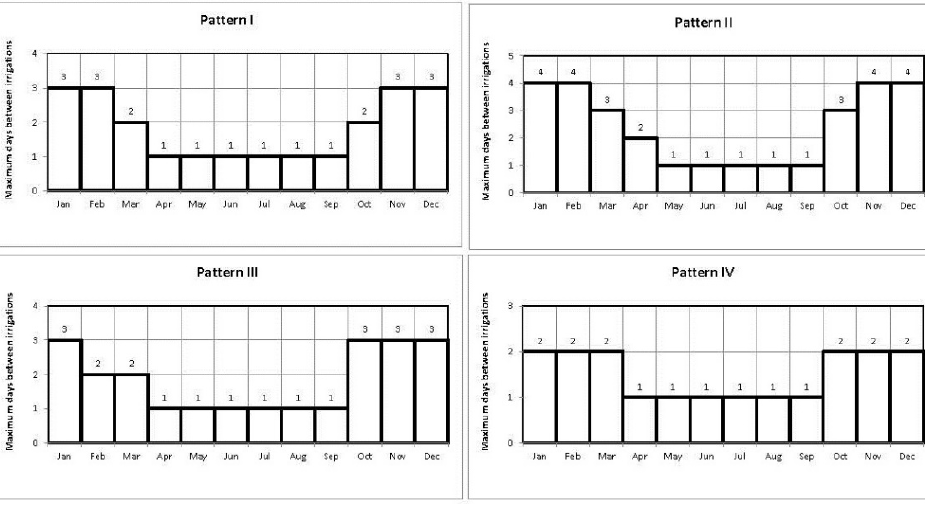
Figure 11. Patterns of irrigation duration.